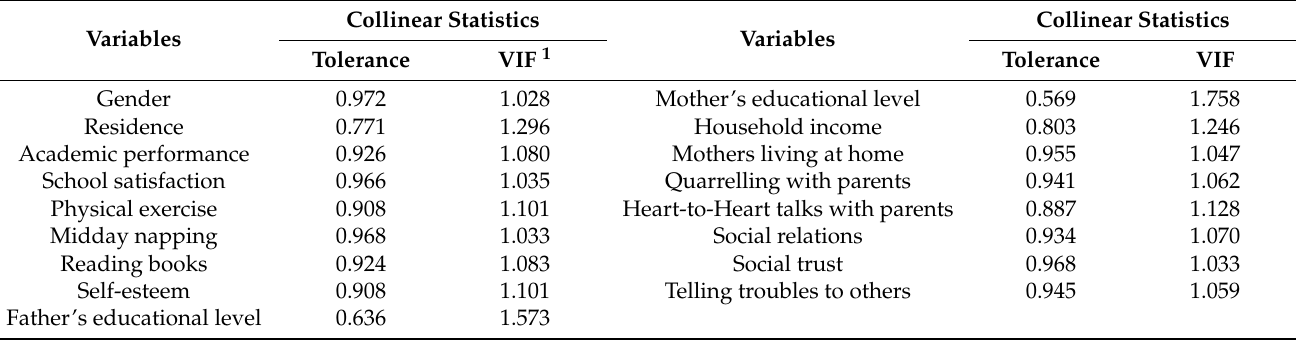
Table 2. Collinearity analysis of factors that associated with subjective well-being (SWB) among Chinese adolescents (N = 2316).